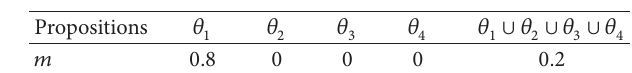
Table 4: Evaluation grades and quantitative